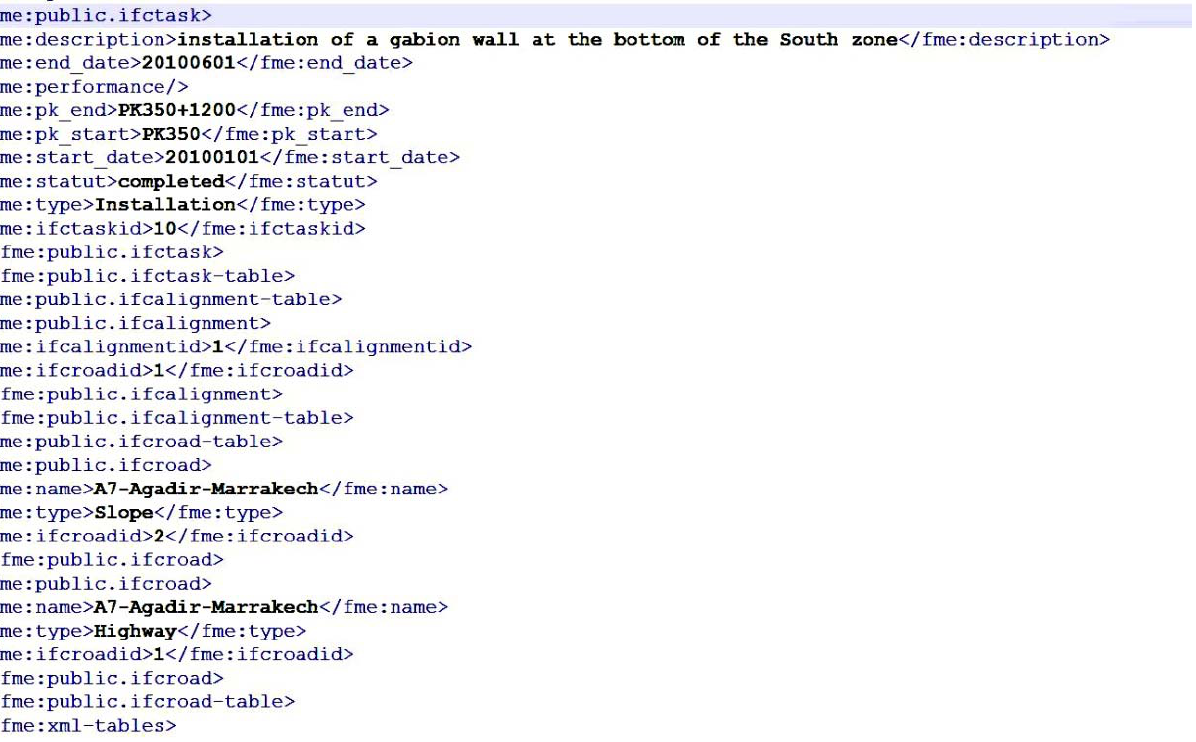
Figure 7. Extract from the ETL mapping procedure.